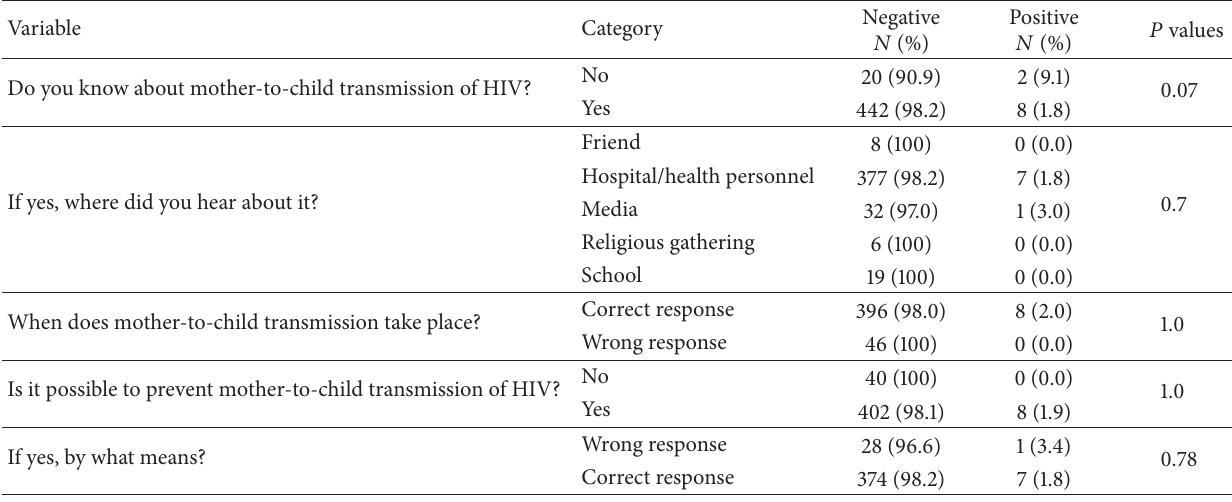
Table 6: Association between knowledge of PMTCT and seroconversion. Variable